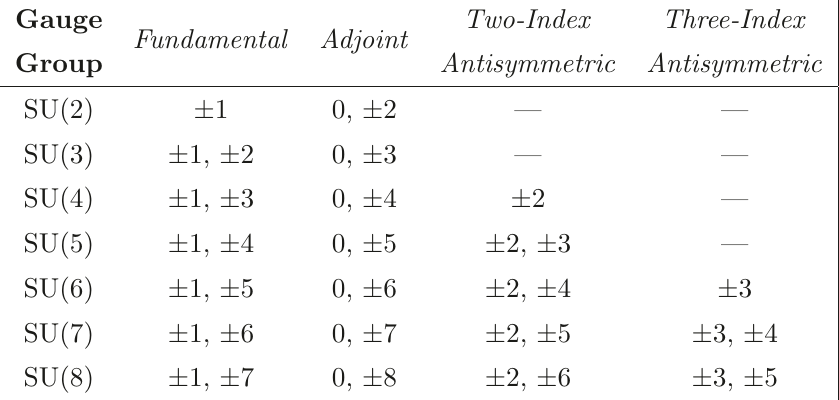
Table 1 . U(1) charges realized by Higgsing SU( N ) according to the Higgsing process on two adjoints described in the text. Each entry denotes the charges coming from a hypermultiplet in a particular representation of SU( N ). Note that hypermultiplets include fields in a representation R and its conjugate ¯R , allowing one to obtain both positive and negative charges from a single hypermultiplet. Dashes indicate representations that either do not occur for a particular gauge group or are equivalent to some other representation. Not all of the representations listed in this table appear in the F-theory models considered